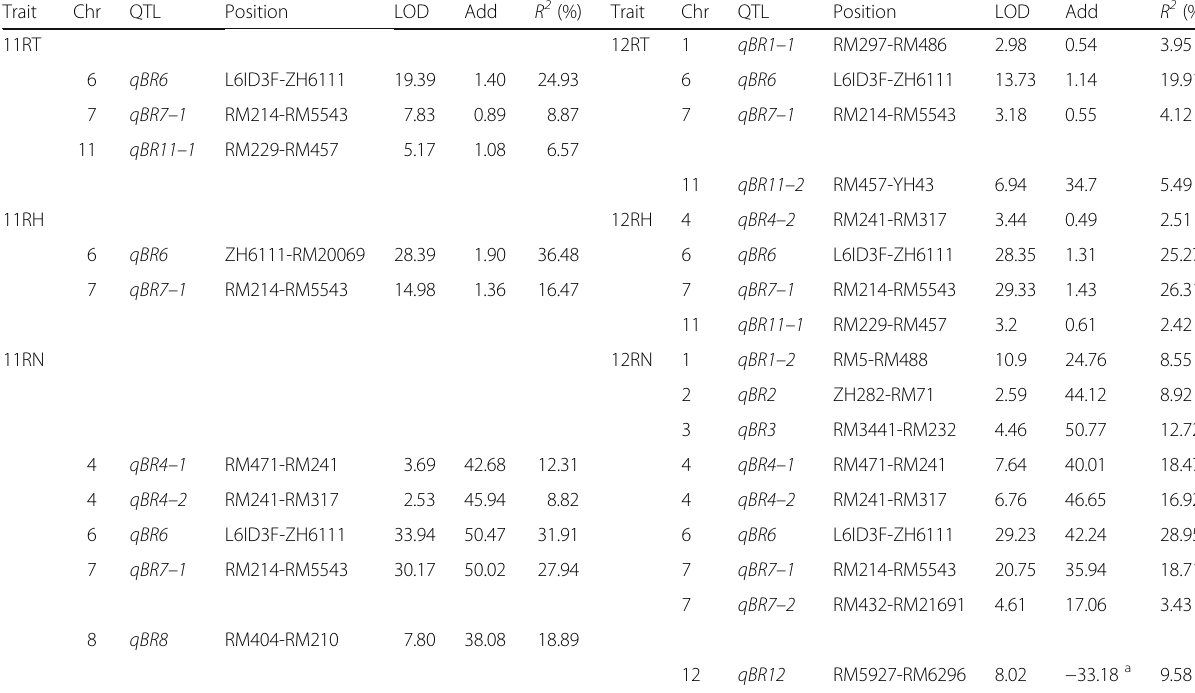
Table 3 QTL mapping results from Jin23B/QingGuAi3 background population in 2 years